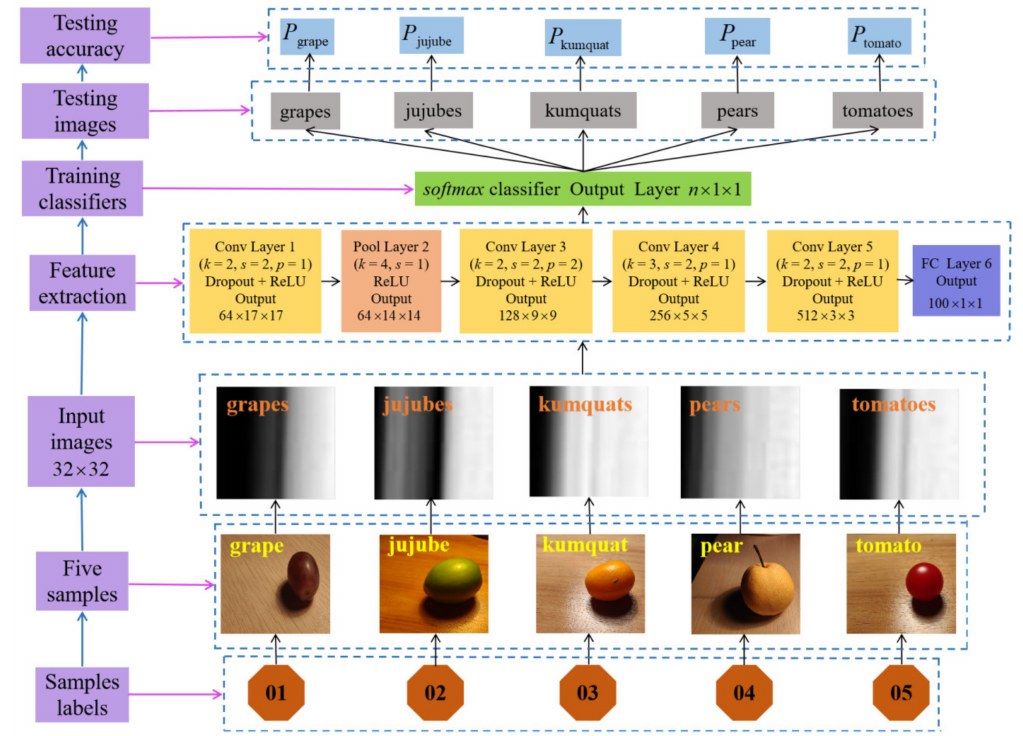
Figure 7. Deep learning spectral classification model framework